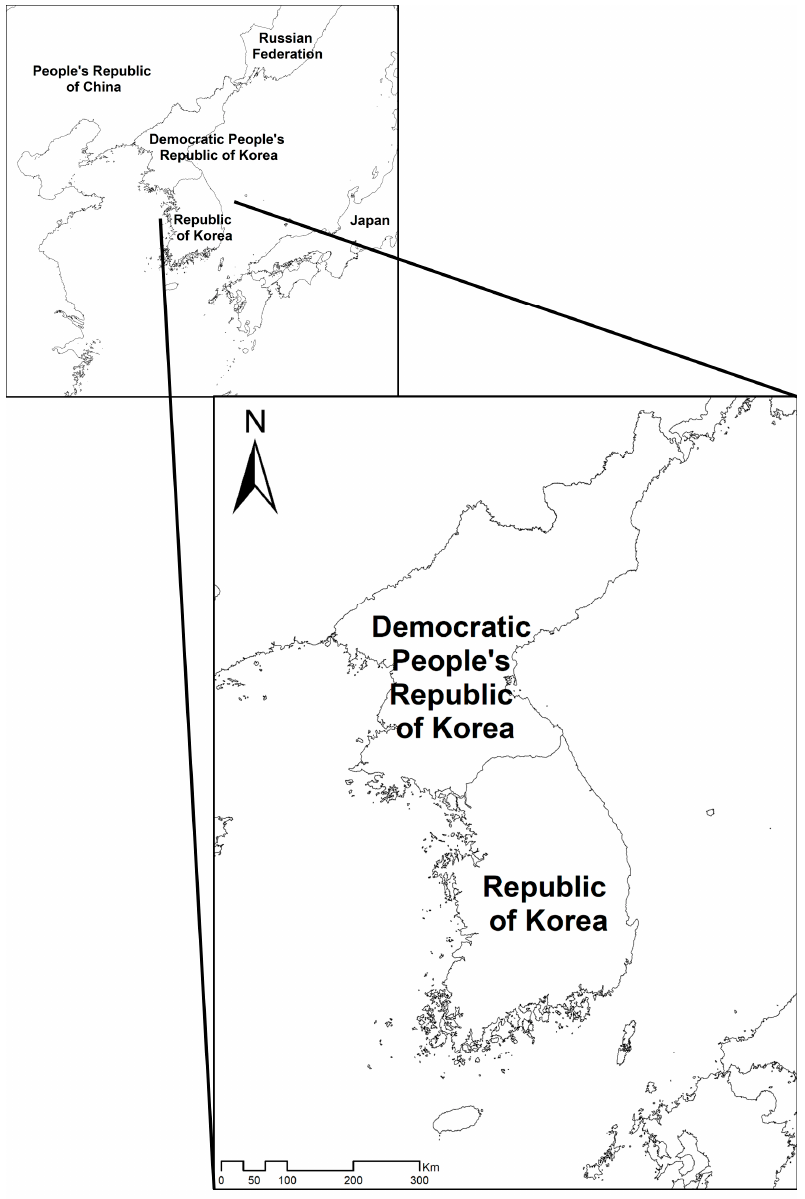
Figure 1. Study site. Korean Peninsula (KP): The Republic of Korea (ROK) in the south and the Democratic People’s Republic of Korea (DPRK) in the north.